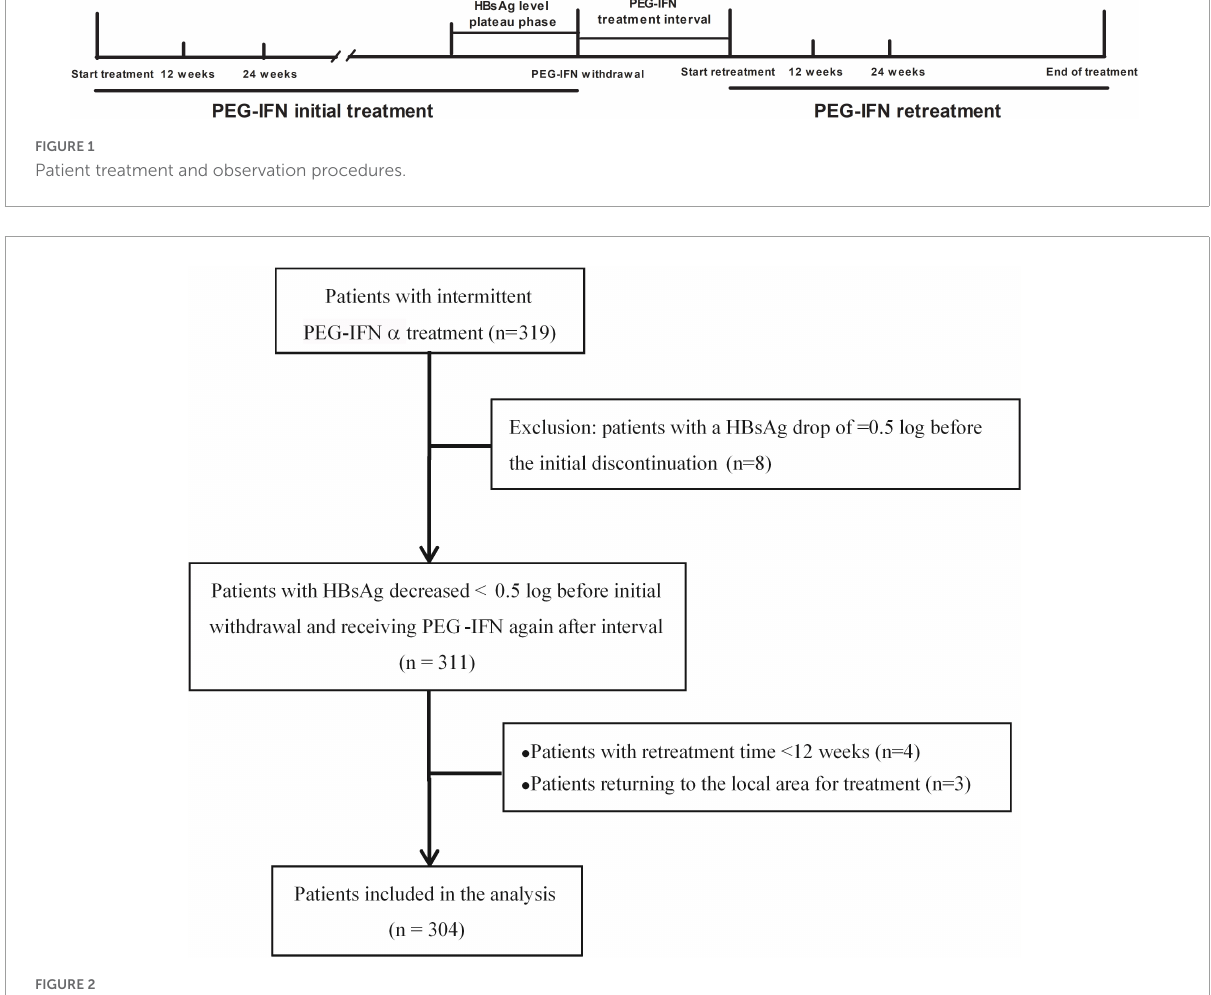
FIGURE2 Patient enrollment